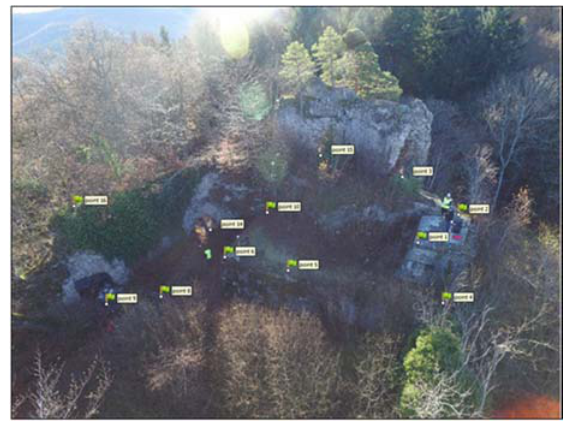
Figure 7: GCPs for model georeferencing.